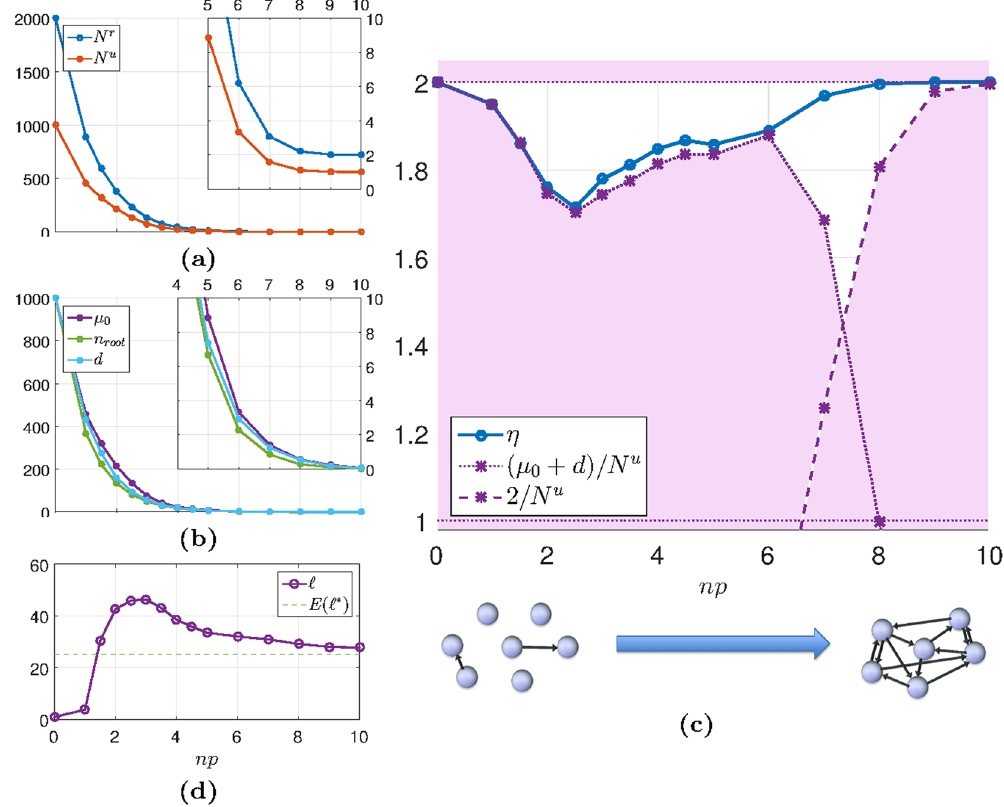
Figure 4. Unilateral controllability of Erdős–Rényi networks. Networks of size n = 1000 are generated with different edge-probabilities, p . For each configuration, 1000 random networks are generated with edge weights sampled from a normal distribution. Averaged values are shown. Note that the x-axis shows np , which is the expected indegree/outdegree for the nodes. ( a ) Both N u and N r decrease as p increases. N u follows μ 0 (shown in ( b )). ( b ) The dimension of   A ( ) , μ 0 , the number roots n root and the number of structurally disjoint subspaces d are shown. The networks in the left-end side of the plot have few edges and many roots. As the networks become more dense, the number of roots decreases and instead dilations appear in the networks. ( c ) The ratio η with its lower and upper bounds are shown. For np ≤ 6, η is always close to its lower bound ( μ 0 + d )/ N u i.e. the extra N r − N u controls needed for unilateral controllability are due to the roots and dilations. When the networks become sufficiently dense there are neither roots nor dilations. Then N r approaches 2, a lower bound that comes from the presence of simple real eigenvalues in the adjacency matrix A . ( d ) The number of real eigenvalues  approaches the constant level predicted by the theory as p